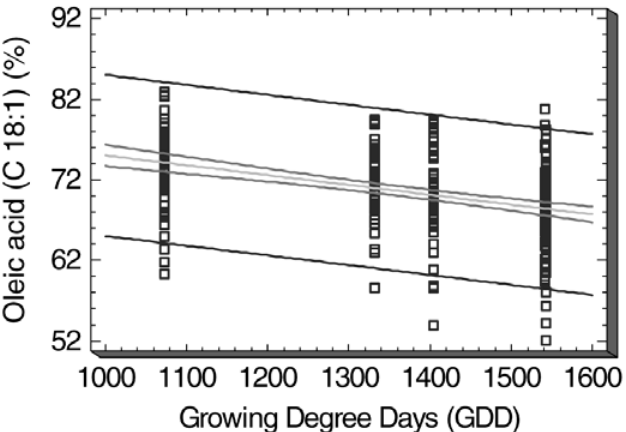
Fig. 4 - Regression between the % content of oleic acid in the TAGs of different cultivars and GDD (population 188 cultivars in total with at least two analytical data in the five years; p≤ 0.01 and r=0.473). On the left, the coolest year (2005), on the right, 2003 (the warmest, practically superposed with 2001) (From: Lom- bardo et al .,